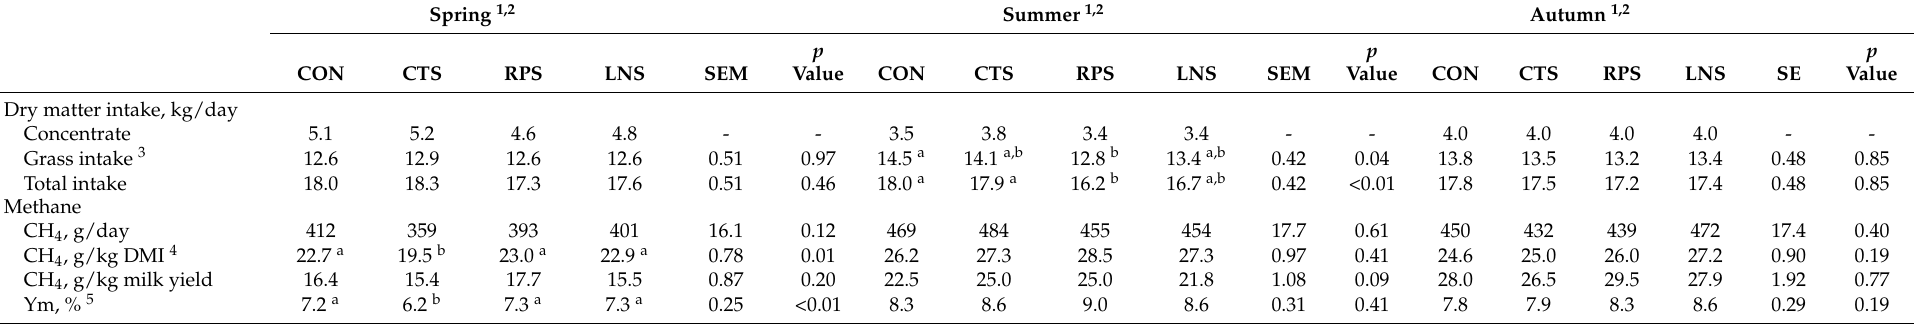
Table 5. Effect of oilseed supplementation on dry matter intake and methane (CH 4 ) production of lactating dairy cows on